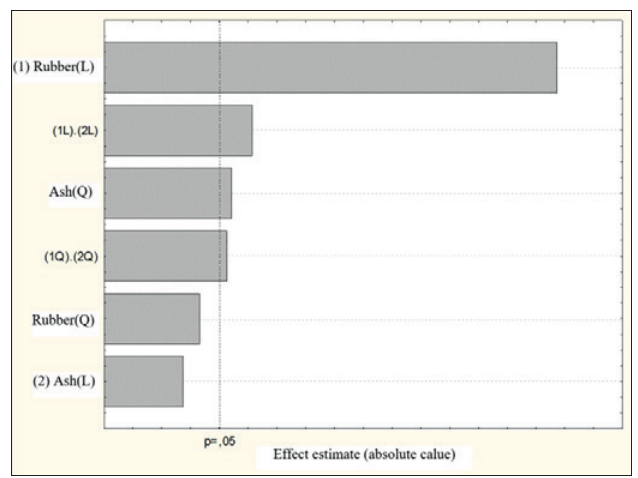
Pareto Chart for the rubber and fly ash effects